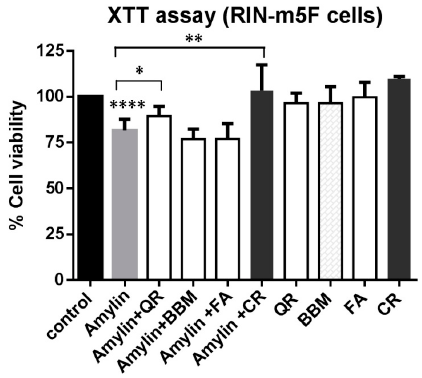
Figure 4. Quercetin reduction of amylin (8–37) cytotoxicity in pancreatic rat insulinoma Rat insulinoma pancreatic (RIN-m5F) β -cells. Cells were treated for 48 h with amylin (75 µM) in the presence or absence of benzbromarone (BBM, 10 µM), quercetin (QR, 10 µM), folic acid (FA, 10 µM), or Congo red (CR, 100 µM), and cell viability was measured using a 2,3-Bis(2-methoxy-4-nitro-5- sulfophenyl)-2H-tetrazolium-5-carboxanilide: XTT assay. The results obtained were normalized to control cells (dimethyl sulfoxide: DMSO treated) and expressed as mean values ± SD ( n = 7 independent experiments). No statistical differences were obtained between the conditions where only the compounds were added and the control. Statistical analysis was carried out using an unpaired t test. * p < 0.05; ** p < 0.01; **** p < 0.0001.